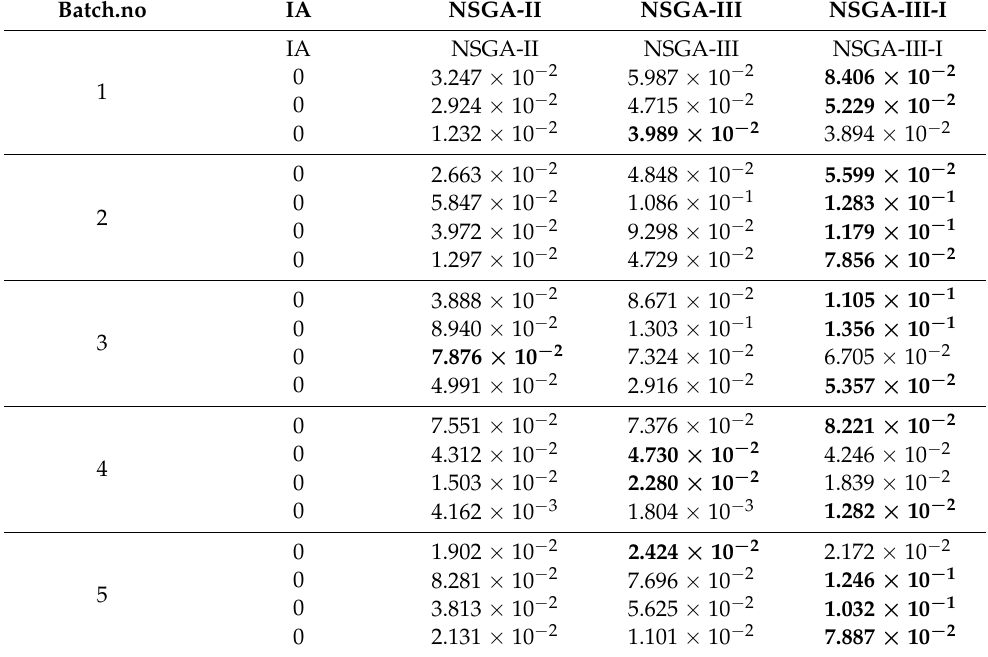
Table A3. Performance comparison between the proposed algorithm and other algorithms on the experimental problem with a batch size of